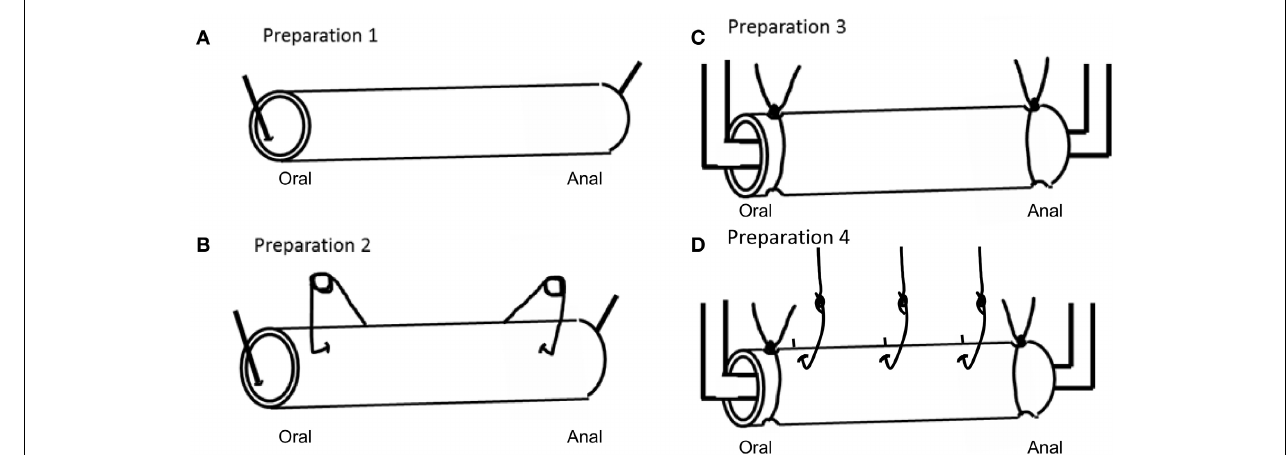
FIGURE 1 | Different types of preparations used to record CMMC activity in isolated whole segments of mouse colon. (A) Preparation 1 is a novel preparation, where video recordings are made from the empty whole colon, with only a single pin inserted at proximal and distal end to anchor the preparation to the colon. No force transducer clips pinch the bowel. (B) Shows preparation 2, where the colon has